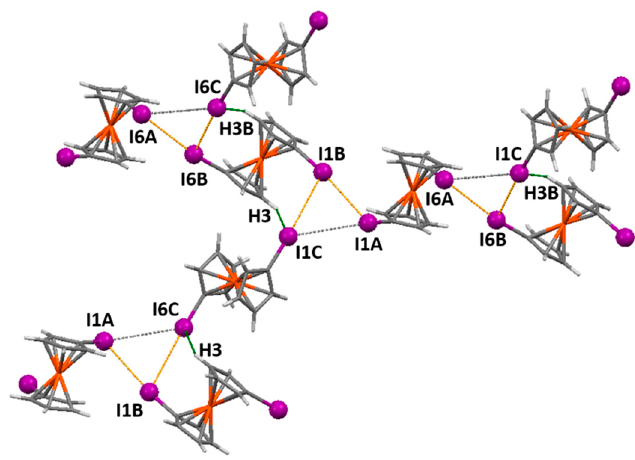
Figure 7. View of part of supramolecular arrangements of (CpI) 2 Fe (halogen bonds in orange, hypothetical type I halogen contacts in grey and C-H · · · I bonds in green).